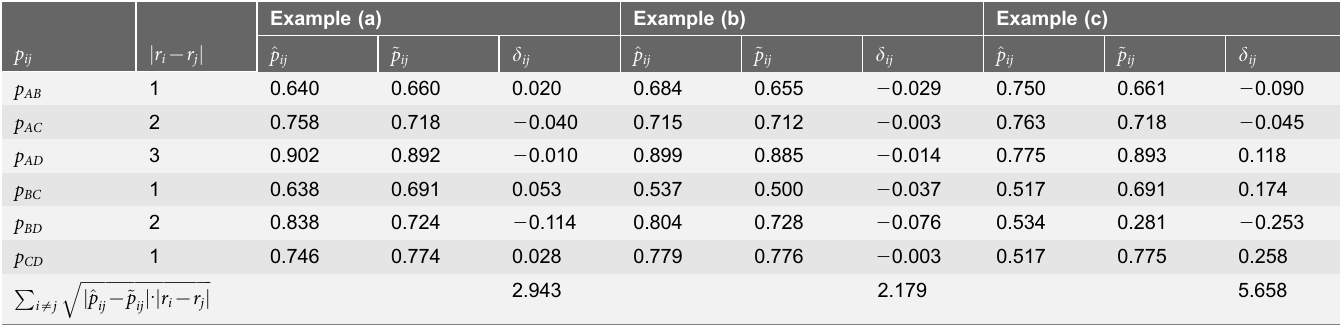
Table 3. Computing the test-statistic for the systemic